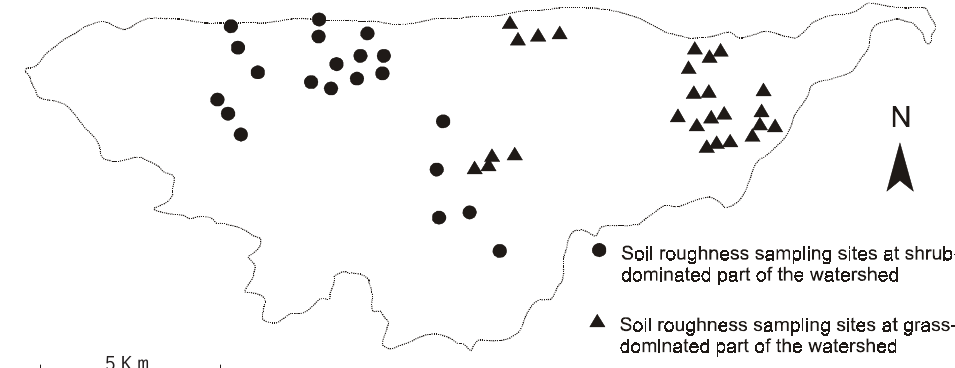
Figure 2. Walnut Gulch Experimental Watershed boundaries with location of soil moisture sampling